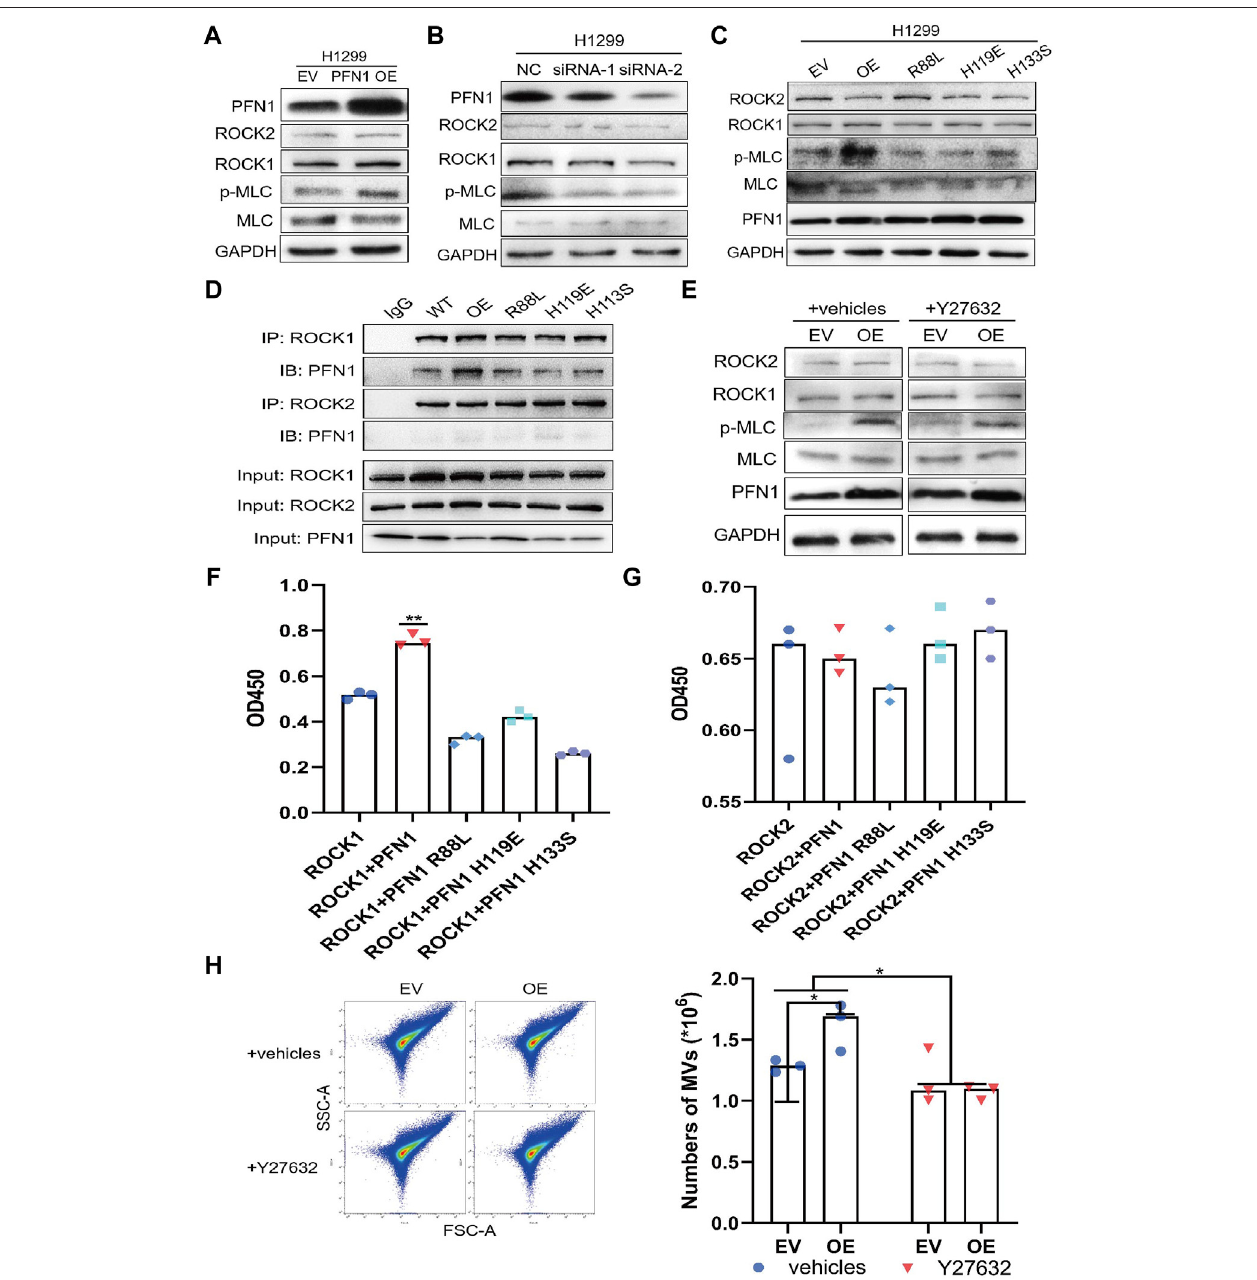
FIGURE5| Mechanismsunderlying thepromotion ofMLCphosphorylation byPFN1. (A,B) Proteinexpression after PFN1 overexpression (A) and knockdown (B) measuredusingwesternblotting. (C) ProteinexpressioninPFN1mutantsmeasuredusingwesternblotting. (D) PFN1interactionswithROCK1/2con fi rmedusingco-IP. (E) Protein expression after treatment with Y27632 (10 µM) measured using western blotting. (F) Effect of PFN1 on ROCK1 activity. ** p < 0.01. (G) Effect of PFN1 on ROCK2 activity. (H) Flow cytometry measuring changes in the amount of MVs after treatment with Y27632; * p < 0.05.